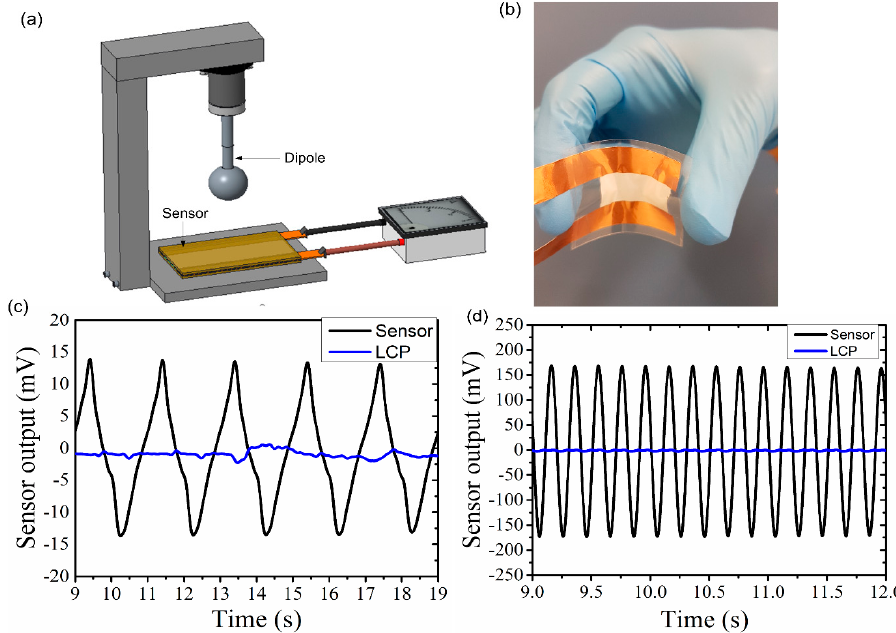
Figure 6. Testing the sensor under low-frequency dynamic loads. ( a ) schematic diagram of the experimental setup. ( b ) image of the flexible PVDF electro spun nanofiber sensor after packaging. ( c , d ) experimental result when the vibrating sphere vibrates at a frequency of 0.5 Hz and 5 Hz, respectively at constant amplitude of 250 mVrms.